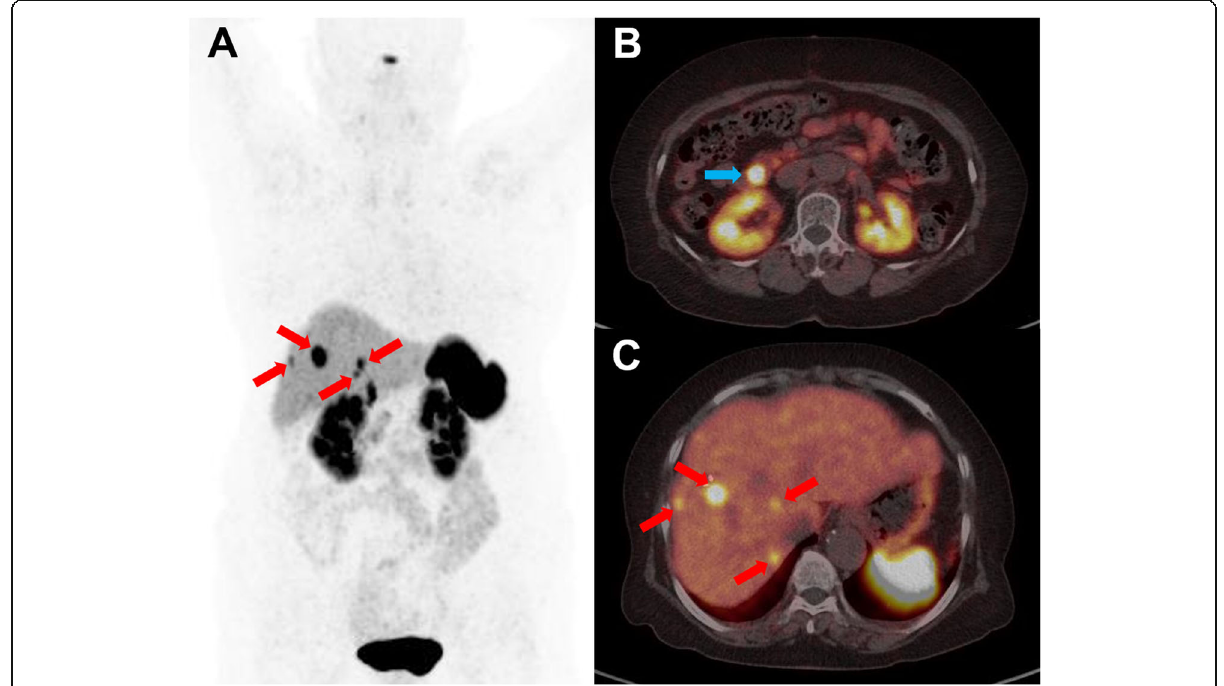
Fig. 3 Representative case of a 77-year-old male with a primary duodenal NET grade 2. Maximal intensity projection (MIP, a ) and trans-axial ( b , c ) [ 68 Ga]Ga-DOTA-TOC PET/CT images show a primary NET at the duodenal second portion (blue arrow) and multiple small hepatic metastases (red arrows) with intense uptake. He had a good ECOG performance status (0), high TLR (11.8), high SUVmax (53.7), and low WTV (8.5), predicting a good prognosis. After lanreotide therapy, no progression was found until 34 months of